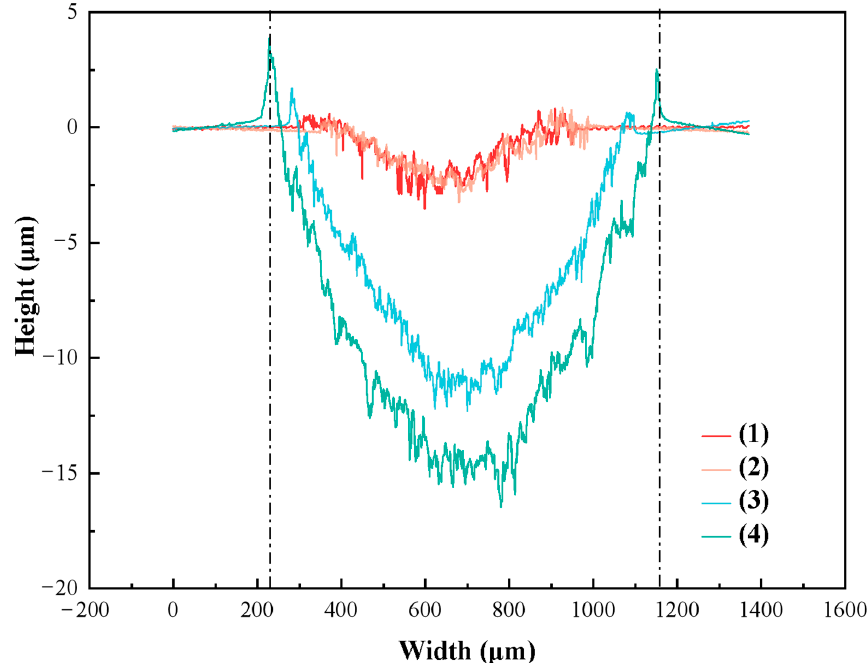
Figure 19. 3D morphology of wear. ( 1 ) is the depth of Fe-based substrate wear; ( 2 ) is the depth of Fe-based alloy coating wear; ( 3 ) is the depth of Ni-based substrate wear; ( 4 ) is the depth of Ni-based alloy coating wear.